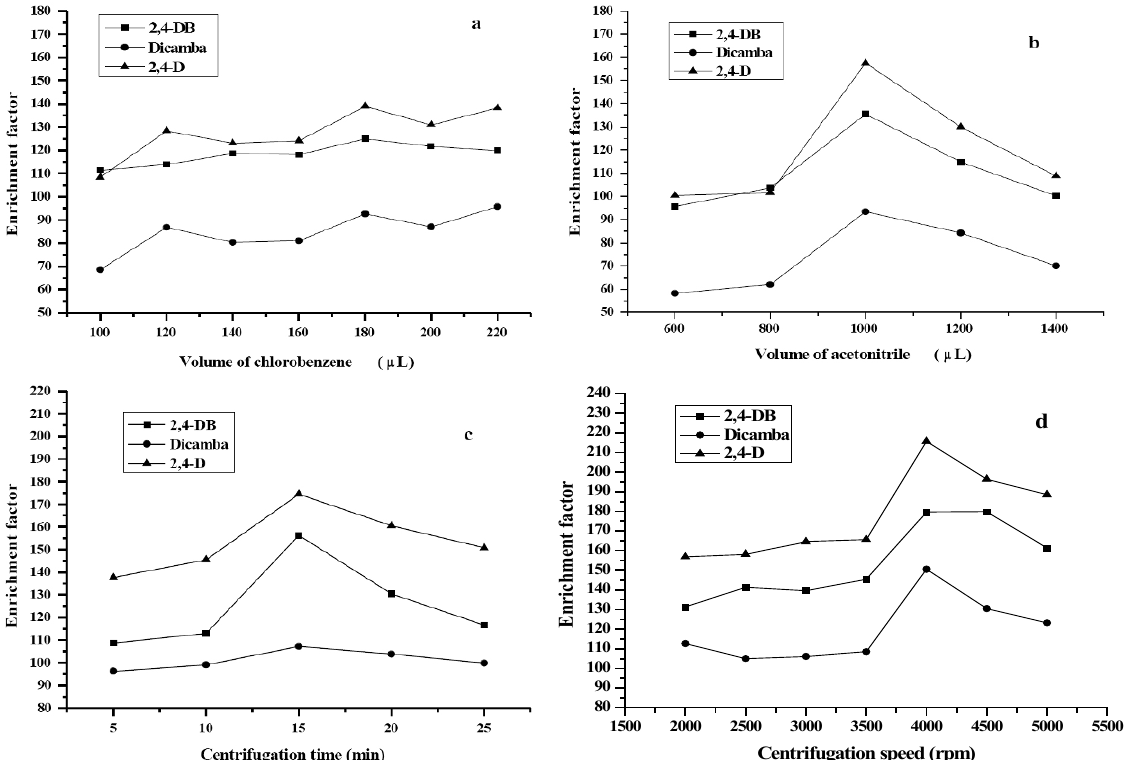
Figure 3. Effect of (a) extracting solvent volume, (b) dispersing solvent volume, (c) centrifugation time and (d) centrifugation speed on the EFs of DLLME for PAs. Extraction conditions: sample volume, 5.0 mL; (a) extracting solvent, chlorobenzene; dispersing solvent, 1000 µL ACN; centrifugation time, 15 min; centrifugation speed, 4000 rpm; (b) extracting solvent, 180 µL chlorobenzene; dispersing solvent, ACN; centrifugation time, 15 min; centrifugation speed, 4000 rpm; (c) extracting solvent, 180 µL chlorobenzene; dispersing solvent, 1000 µL ACN; centrifugation speed, 4000 rpm; (d) extracting solvent, 180 µL chlorobenzene; dispersing solvent, 1000 µL ACN; centrifugation time, 15 min. The MEKC separation conditions were the same as those described in Fig.